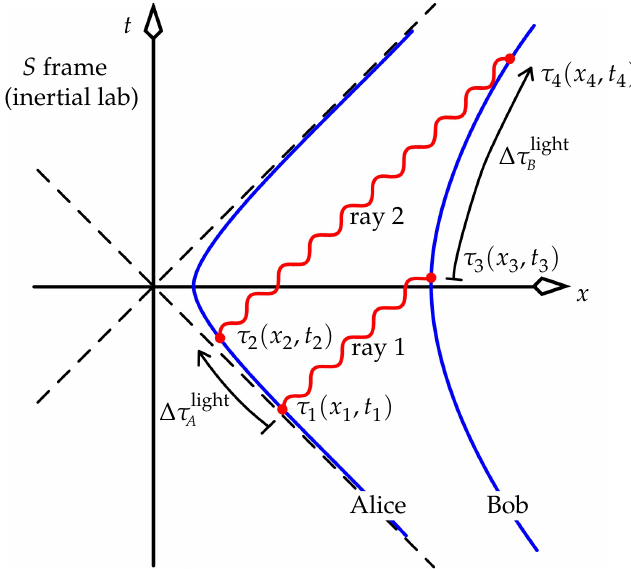
Figure 6. Alice sends Bob two light rays. These can just as well be envisaged as successive crests of a single light